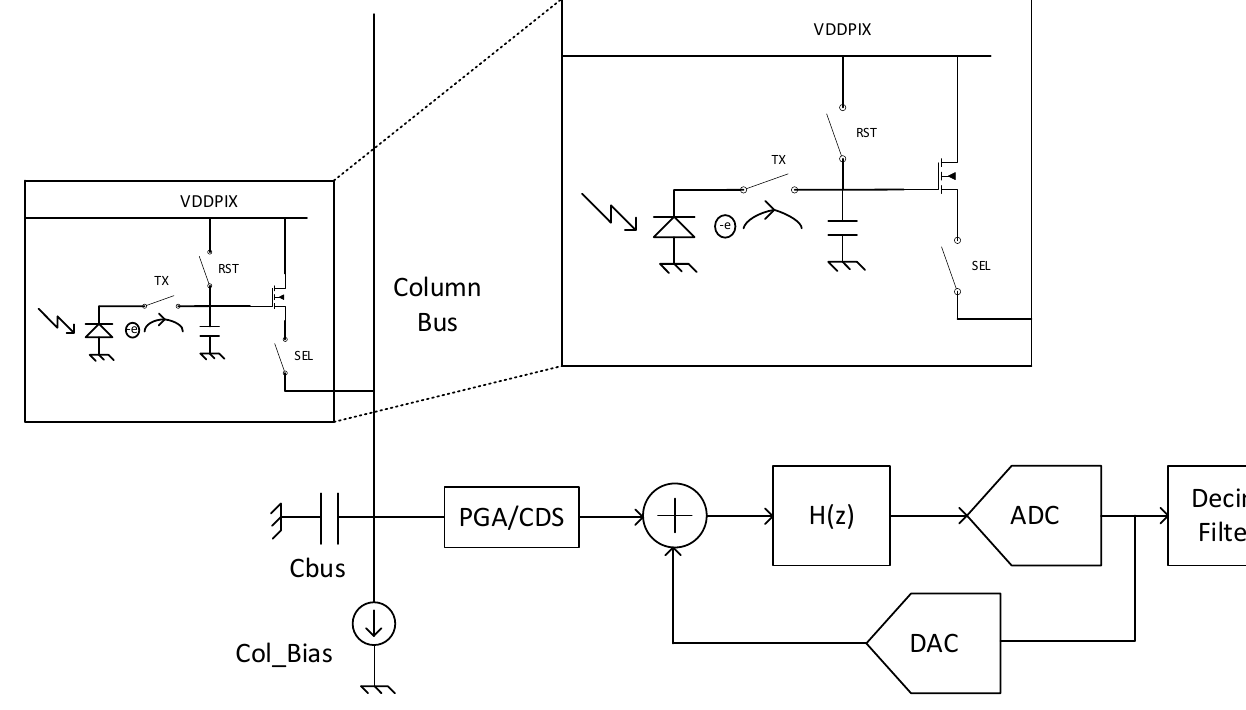
Figure 14. Simplified column readout structure used in this research work.